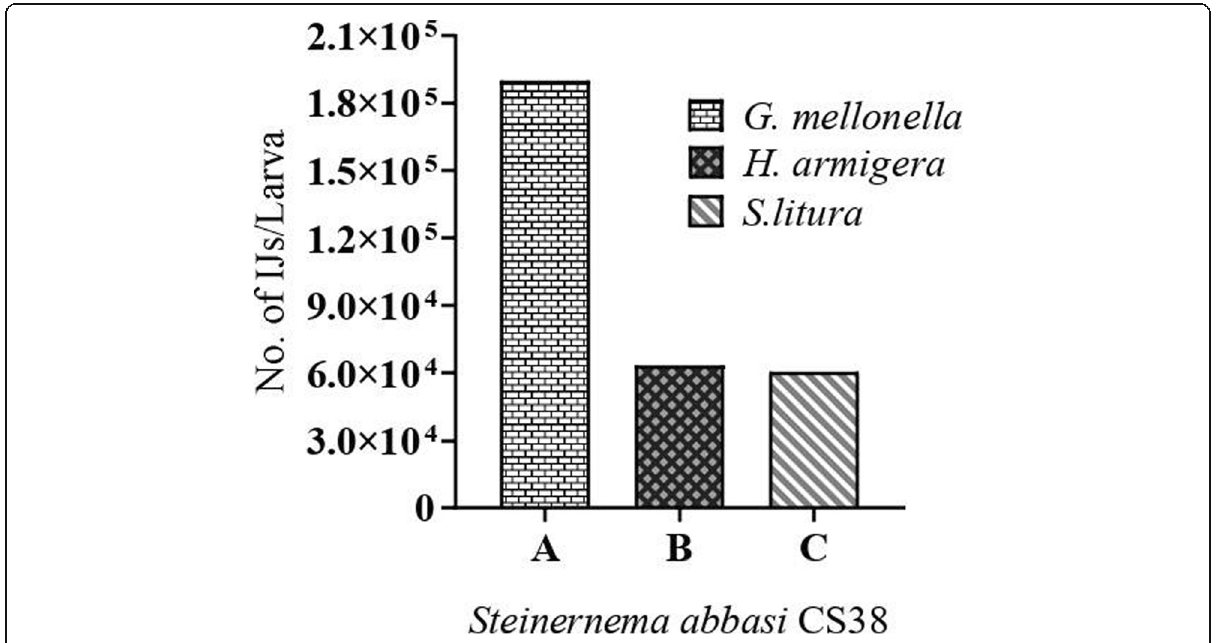
Fig. 5 Production of IJs in G. mellonella , H. armigera and S. litura at 100 IJs/Larva doses of Steinernema abbasi isolate